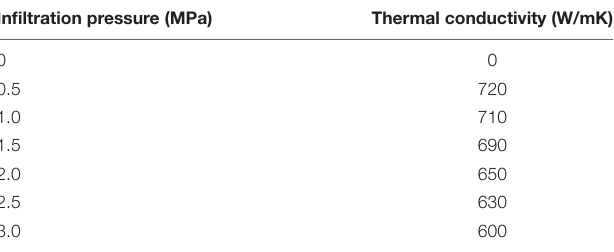
TABLE 6 | Infiltration pressure v/s thermal conductivity (at 800 ◦ C) (Zhang et al., 2014). Infiltration pressure (MPa)